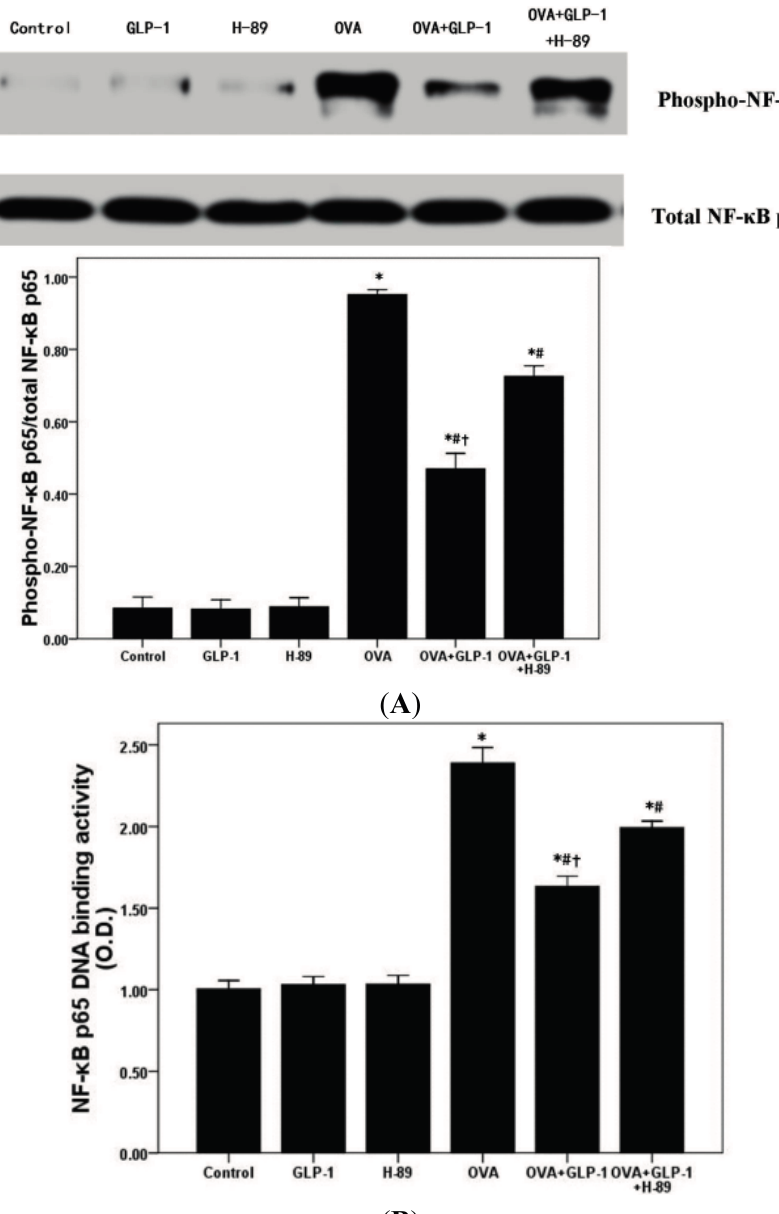
Figure 6. GLP-1 blocks OVA-induced NF- κ B activation and DNA binding activity in lung. ( A ) Western blotting was used to analyze the phosphorylation of NF- κ B p65 in lung; ( B ) DNA binding activity of NF- κ B p65 was measured by a TransAM™ p65 transcription factor ELISA kit. Each bar represents the mean ± SD of 10 mice. * p < 0.05 compared with Control. # p < 0.05 compared with OVA. † p < 0.05 compared with OVA + GLP-1 +